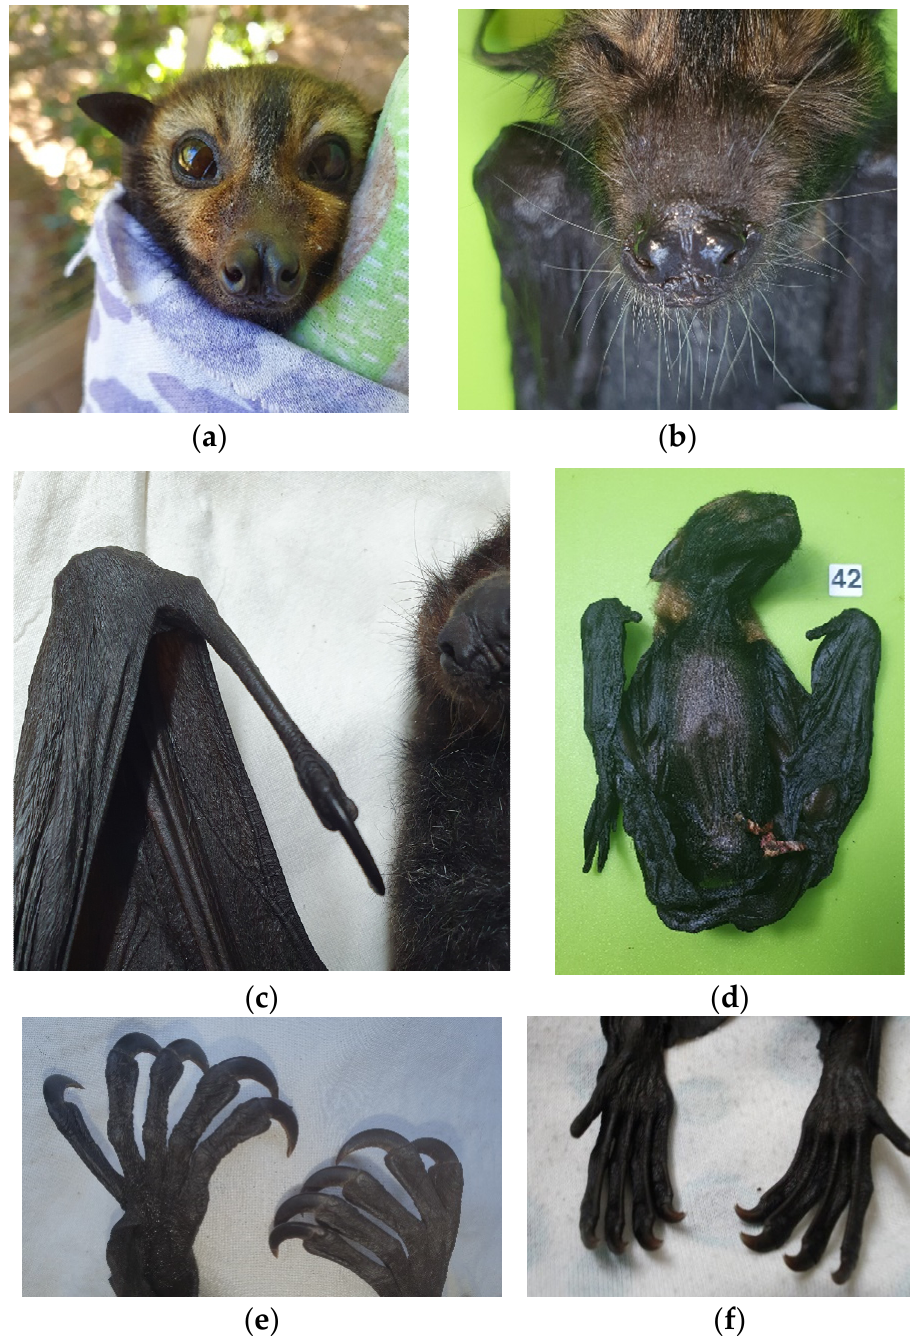
Figure 2. Whisker, nare and claw deformities in spectacled flying fox neonates. Normal nares and whiskers ( a ); wiry whiskers and abnormal development of nares ( b ); normal thumb claw ( c ); abnormal development of thumb claws, missing thumb claws ( d ); normal hind claws ( e ); abnormal hind claw development, missing toe ( f ).